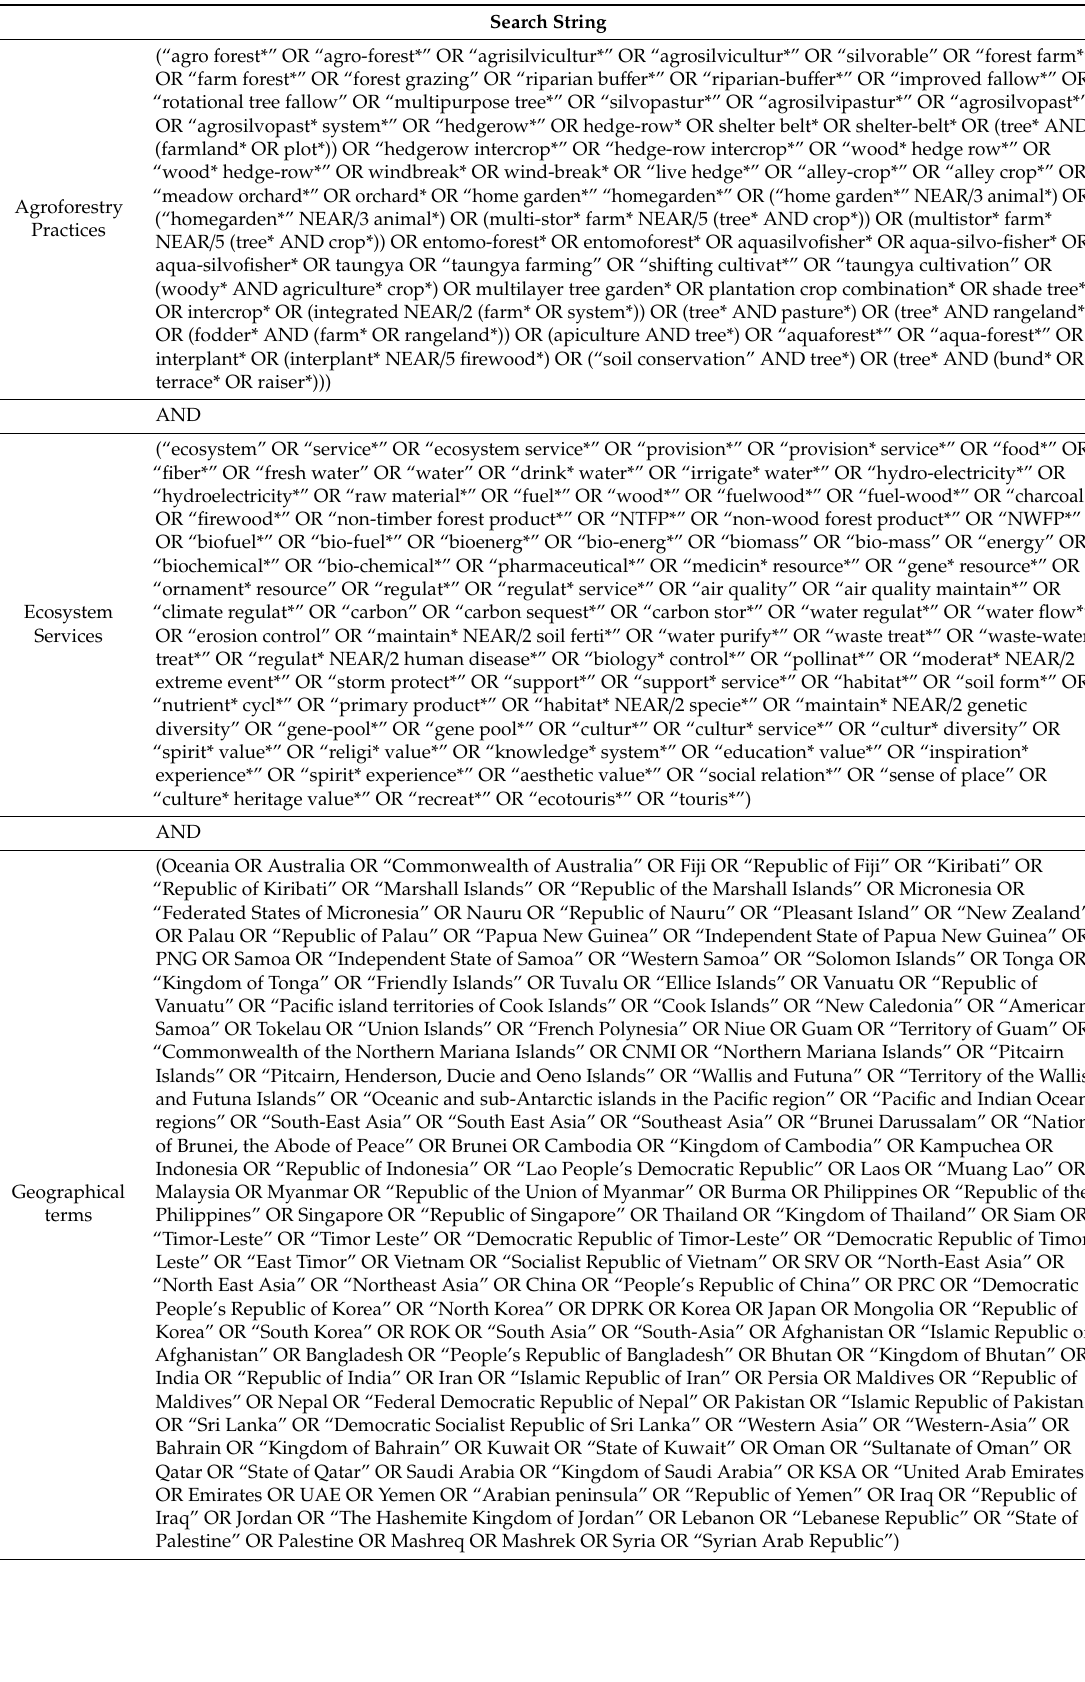
Table A1. List of search terms in English